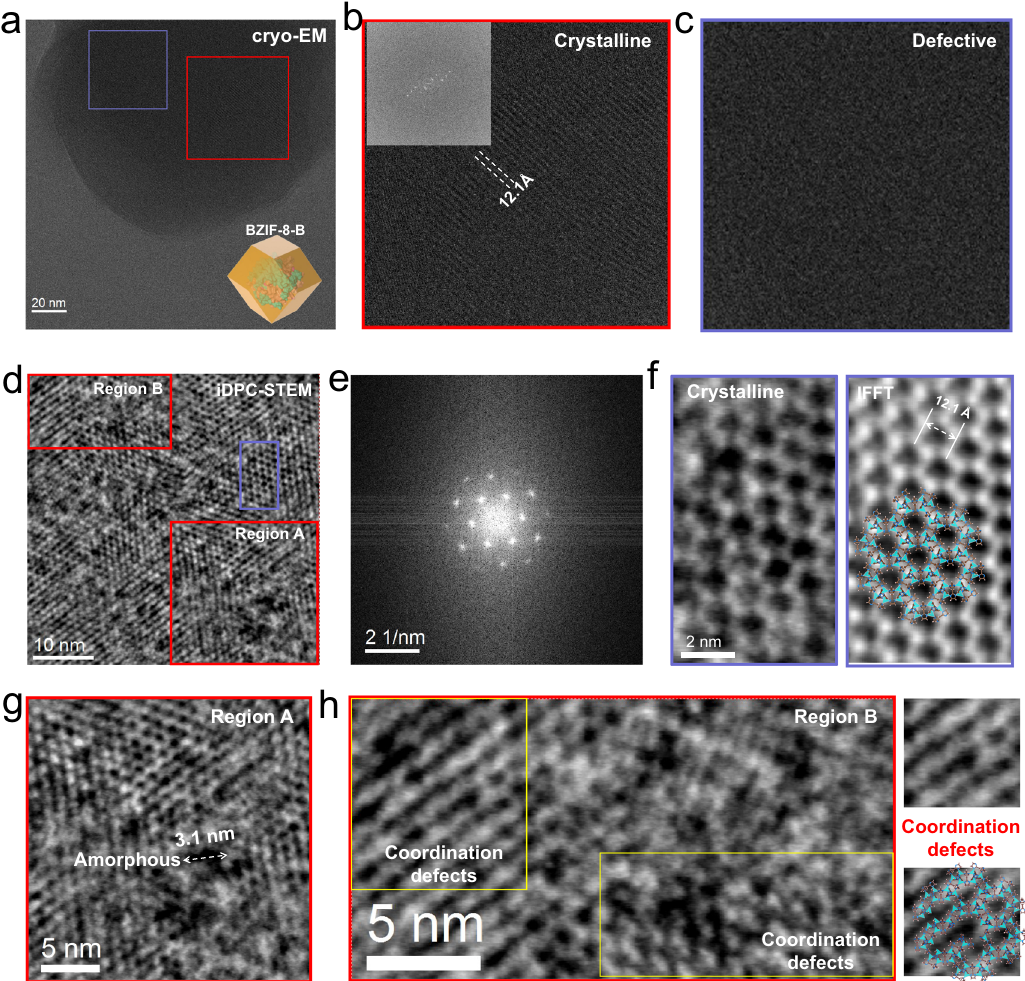
Fig. 3 High-resolution structure imaging of BZIF-8-B. The cryo-EM structure ( a ) of BZIF-8-B, and the ampli fi ed images of the selected red ( b ) and pink ( c ) area in ( a ). The insert in ( b ) was the FFT pattern. The iDPC-STEM image ( d ) and the corresponding FFT pattern ( e ) of BZIF-8-B from the [111] projection. ( f ) The ampli fi ed iDPC-STEM image of the selected pink area (left), and the corresponding inverse FFT (IFFT) pattern (right). It showed the atomic-resolution hexagonal honeycomb cavities. The ampli fi ed iDPC-STEM image of the selected red area: Region A ( g ) and Region B ( h ). The detailed analysis presented the amorphous phase and coordination